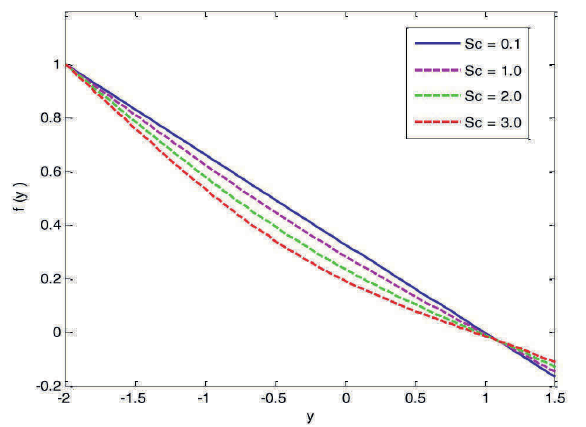
Fig. 17: Impact of thermal slip parameter γ on temperature.